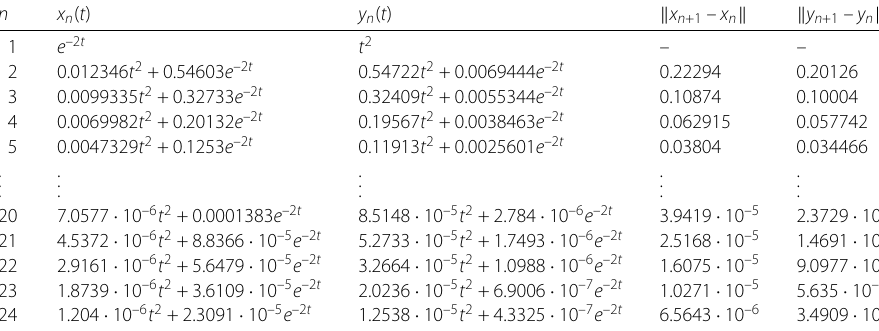
Table 3 Computational results of Case 2 for Example 5.2